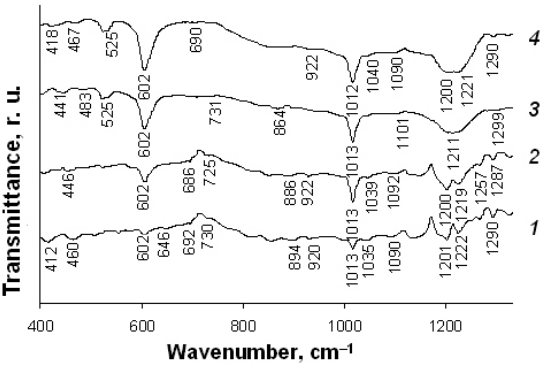
Figure 1. IR spectra of PA treated in 0.1 mol dm -3 K